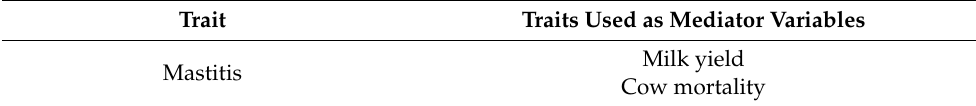
Table 2. Mediator variables used in the regression analyses for the regarded traits.